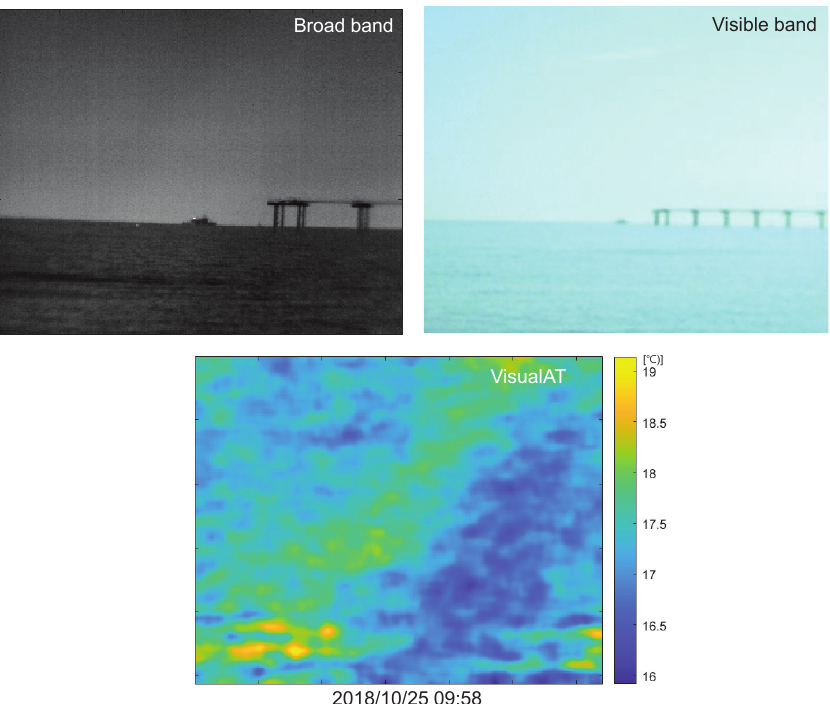
Figure 26. Remote air temperature image visualization example from an outdoor sea environment: (top left) broad band image; (top right) visible band image, (bottom) VisualAT-based air temperature image.